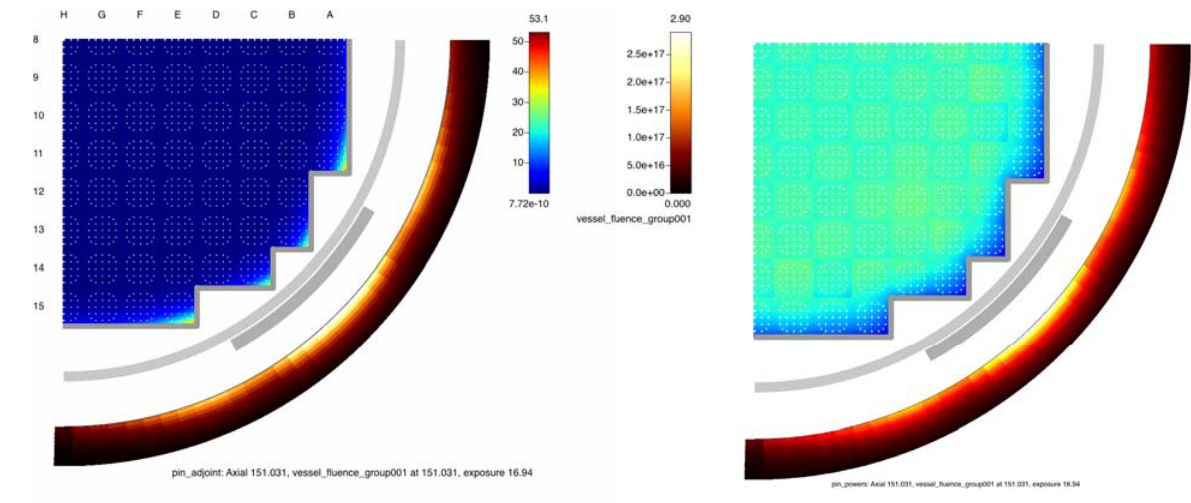
Figure 5: Example of visualizing the results of a VERA ex-core simulation of WBN1 with